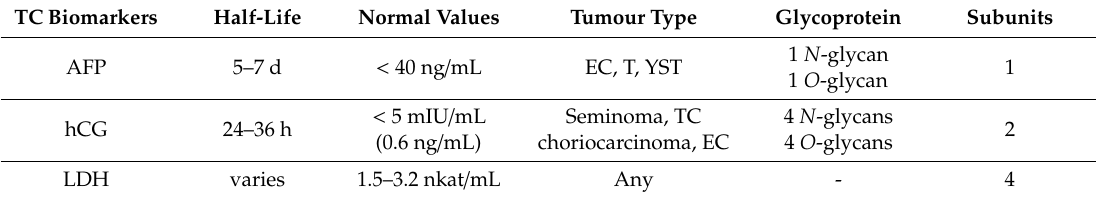
Table 1. Basic characteristics of currently used TC biomarkers. Update based on Ref. [18]. TC Biomarkers Half-Life Normal Values Tumour Type Glycoprotein Subunits AFP 5–7 d Seminoma,